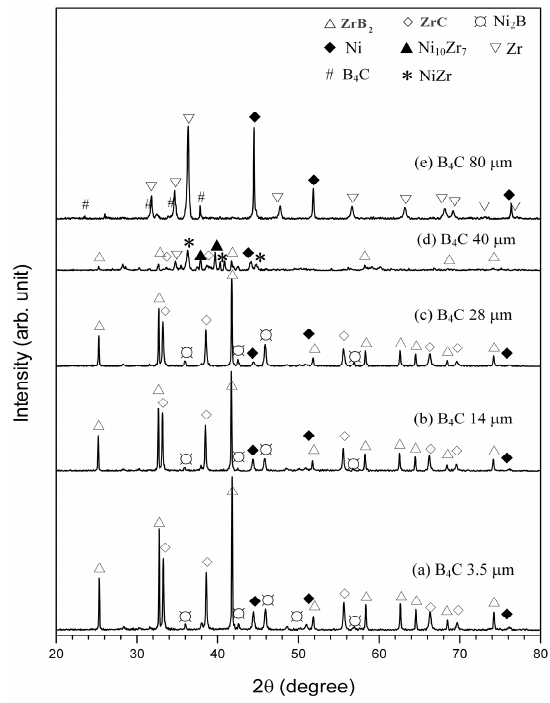
Figure 8. XRD patterns for SHS products of the 30 wt.% Ni-Zr-B 4 C system with various B 4 C particle sizes: (a) 3.5 μ m, (b) 14 μ m, (c) 28 μ m, (d) 40 μ m, and (e) 80 μ m.